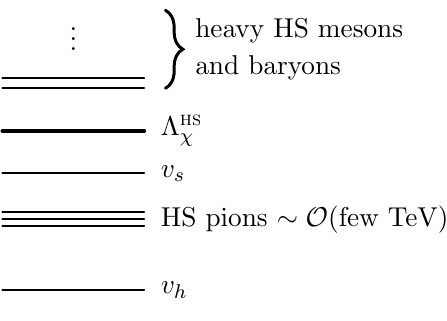
Figure 1 . Spectrum of hidden sector